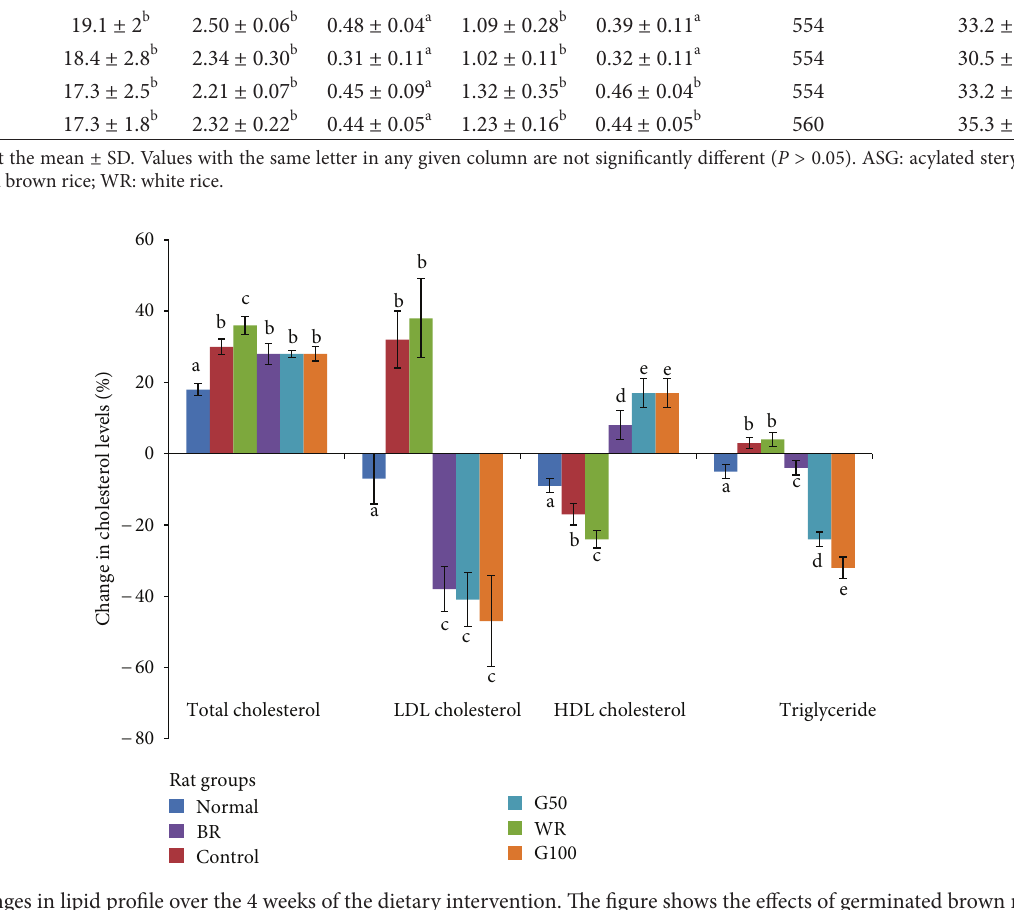
F 1: Changes in lipid pro�le over the 4 weeks of the dietary intervention. e �gure shows the effects of germinated brown rice (GBR) on total cholesterol, LDL cholesterol, HDL cholesterol, and triglycerides in type 2 diabetic rats over the 4 weeks of the dietary intervention compared with the effects of brown rice (BR) and white rice (WR) ( /group). e data represent the means of each group, and the error bars represent SDs. Bars with the same letters are not signi�cantly different ( 𝑛𝑛 𝑛 𝑛 𝑃𝑃 >